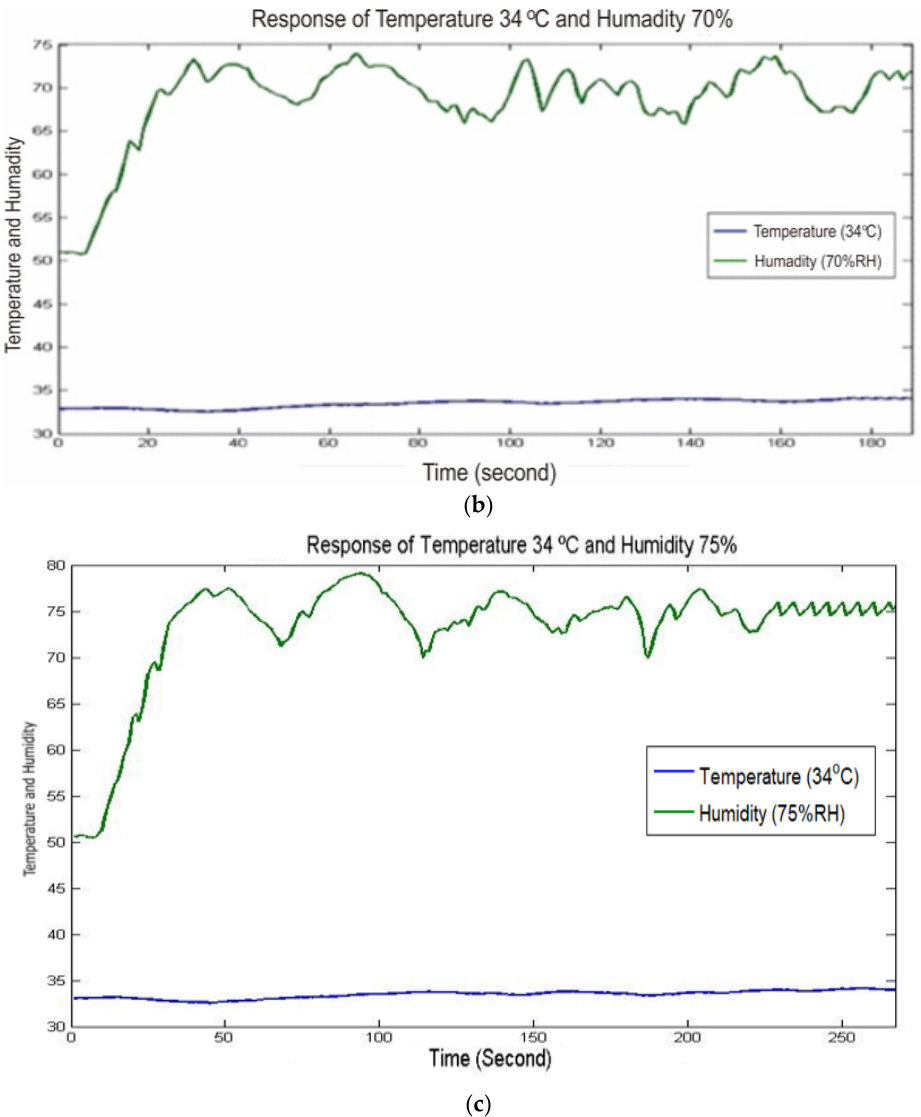
Figure 12. ( a ) System response for temperature 34 °C and humidity 60%, ( b ). System response for temperature 34 °C and humidity 70% and ( c ) System response for temperature 34 °C and humidity 75%.